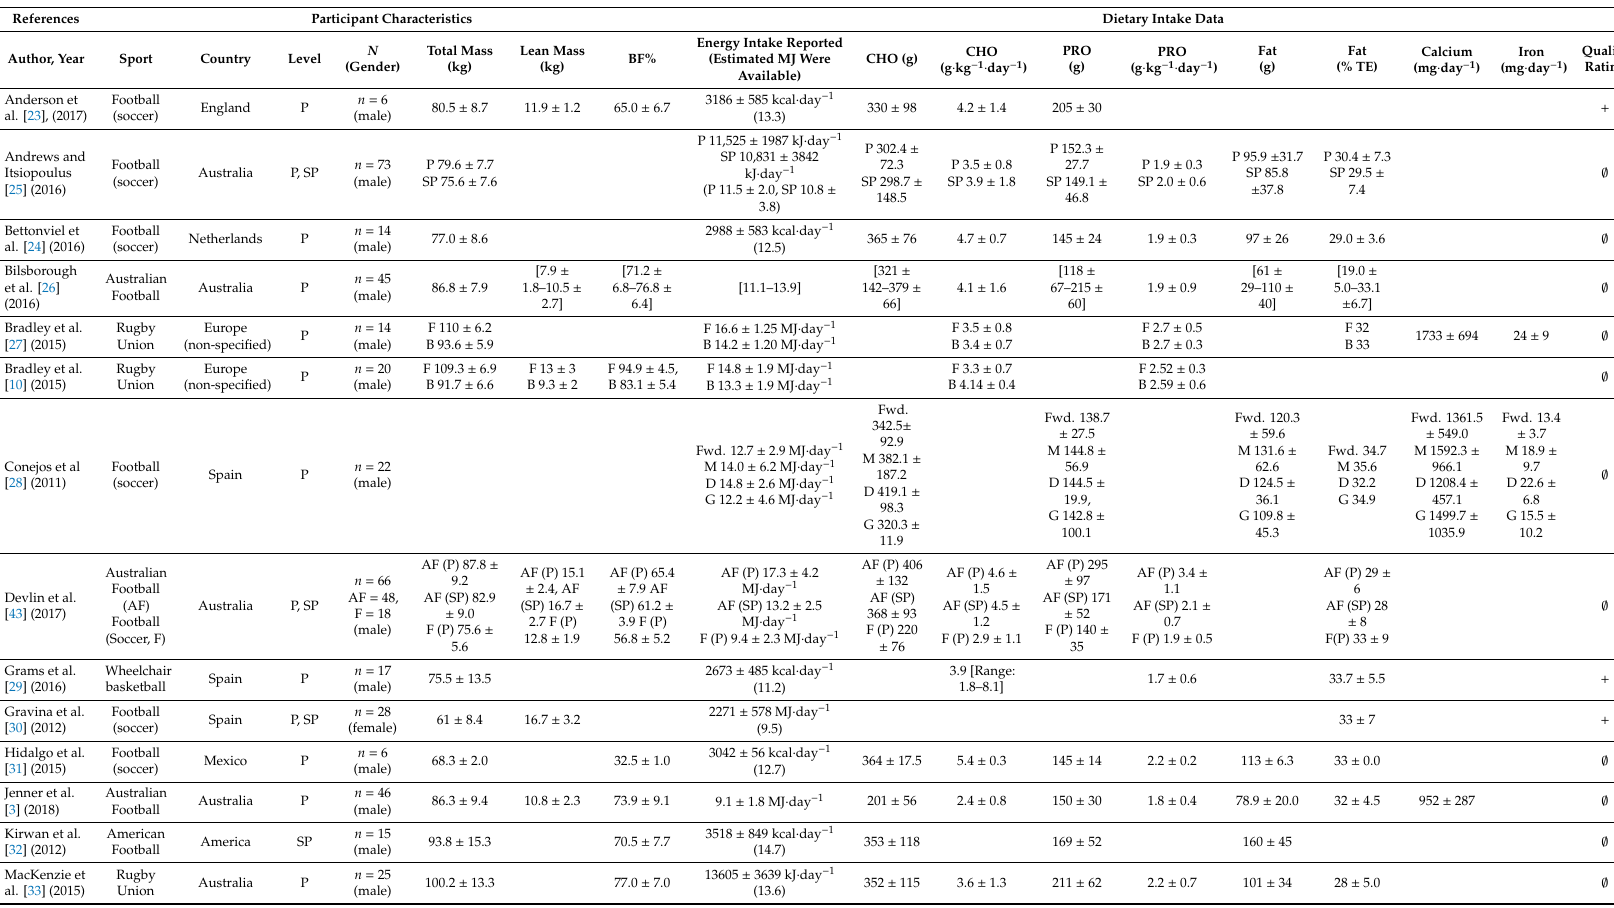
Table 4. Reported energy, macronutrient and micronutrients intakes of male and female professional and semi-professional team sport